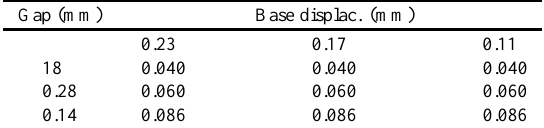
Fig. 8. Effect of partial treatment on performance of MCLD. Table 2 Effect of gap and base displacement on damping ratio (magnets in attraction)